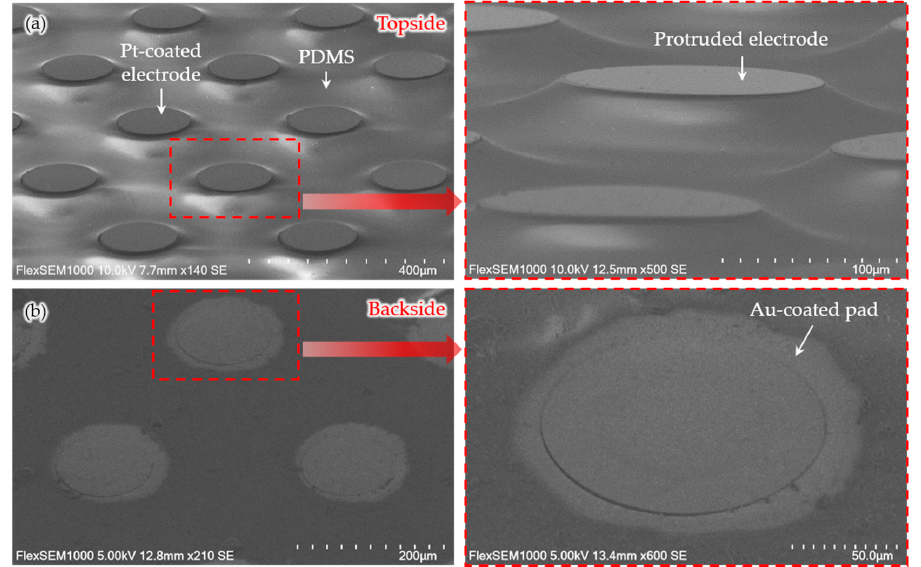
Figure 5. SEM images of the microelectrodes. ( a ) Three-dimensionally protruded electrodes created by the pressing process using an elastic lid. ( b ) Au-coated connection pads on the opposite side of the electrodes.